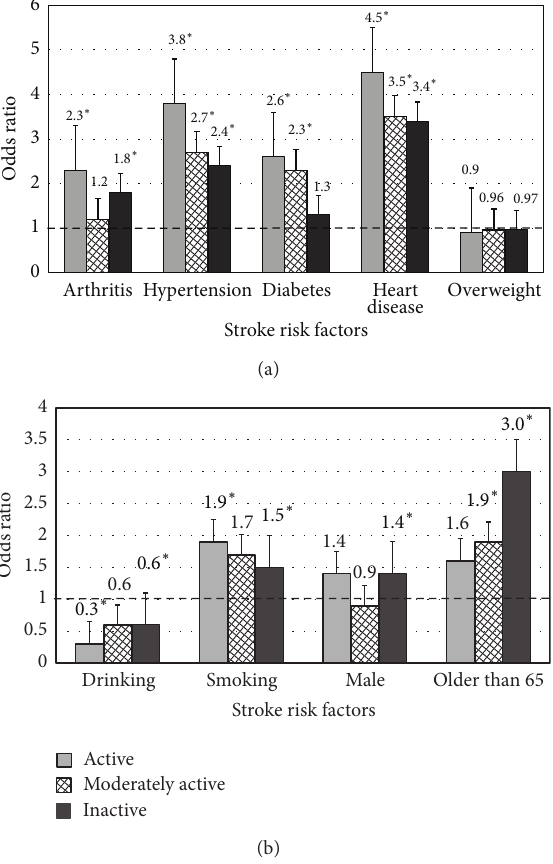
Figure 2: Odds of stroke-related risk factors according to physical activity level. ∗ denotes significance at 𝑃 < 0.05 . Referent = individuals within each physical activity category without the risk factor of